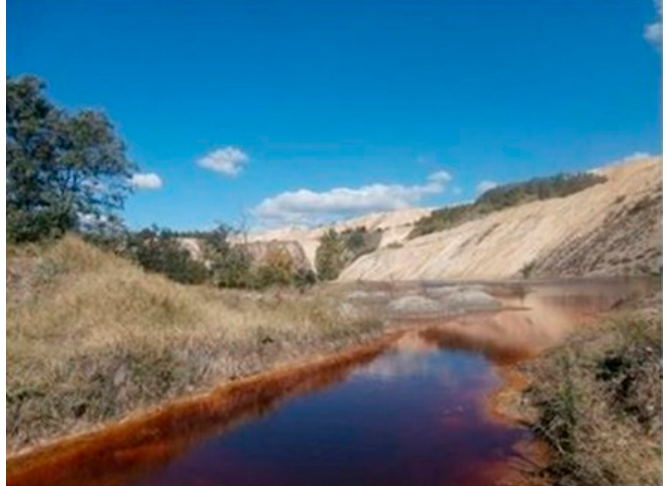
Figure 1. The Robule Lake—example of acid mine drainage (AMD) in the area of the copper ore mine treatment plant in the southeast of Serbia.